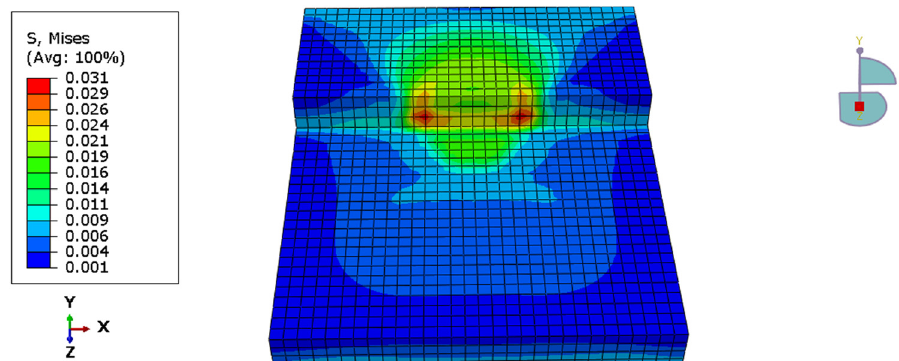
Figure 15: Stress distribution on soil behind thrust block ( MPa ) .